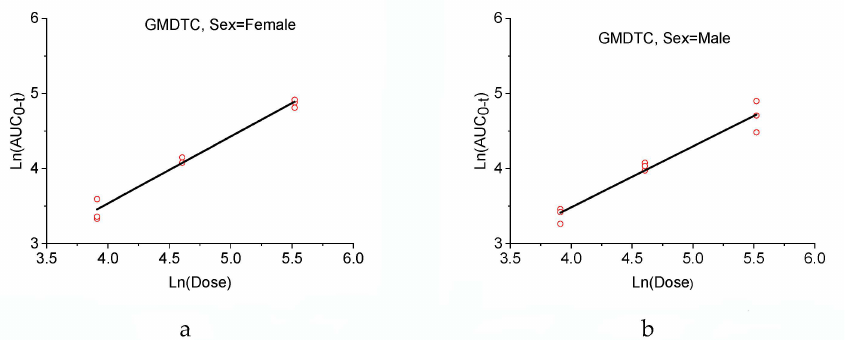
Figure 3. ( a ) Female rats plasma Ln(AUC 0-t )–Ln(Dose) regression curve of GMDTC at dosages of 50, 100 and 250 mg/kg; ( b ) Male rats plasma Ln(AUC 0-t )–Ln(Dose) regression curve of GMDTC at dosages of 50, 100 and 250